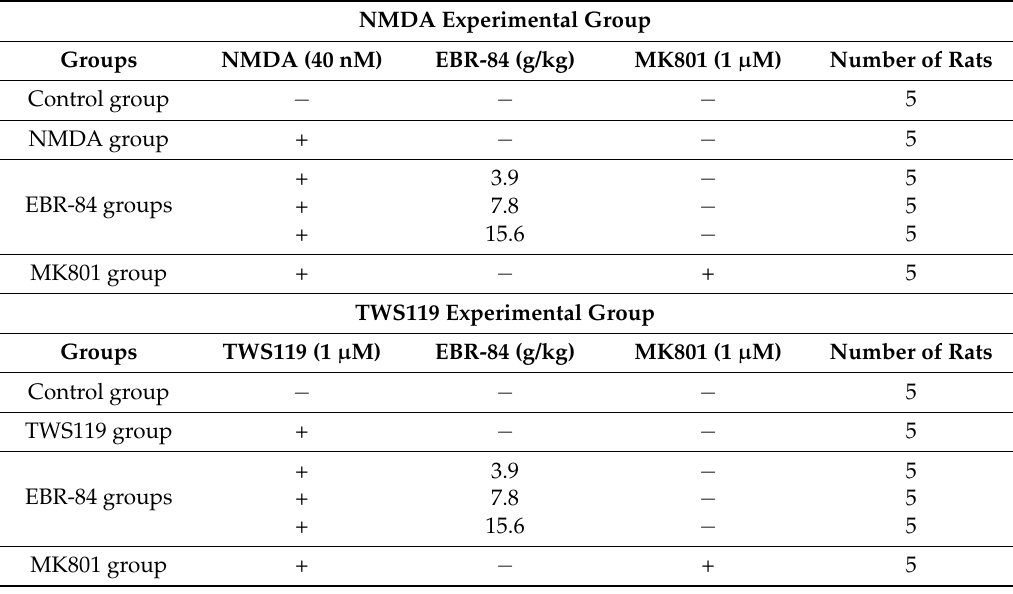
Table 1. The protocol of animal grouping and drug treatment. (“+” or “ − ” means NMDA, EBR-84, and MK801 were given or ungiven to the